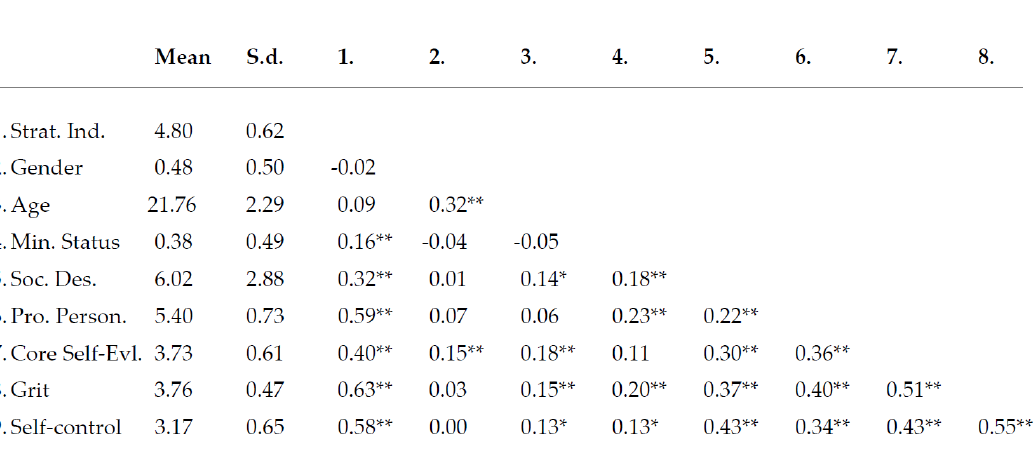
Table 1. Descriptive Statistics and Zero-Order Correlations.